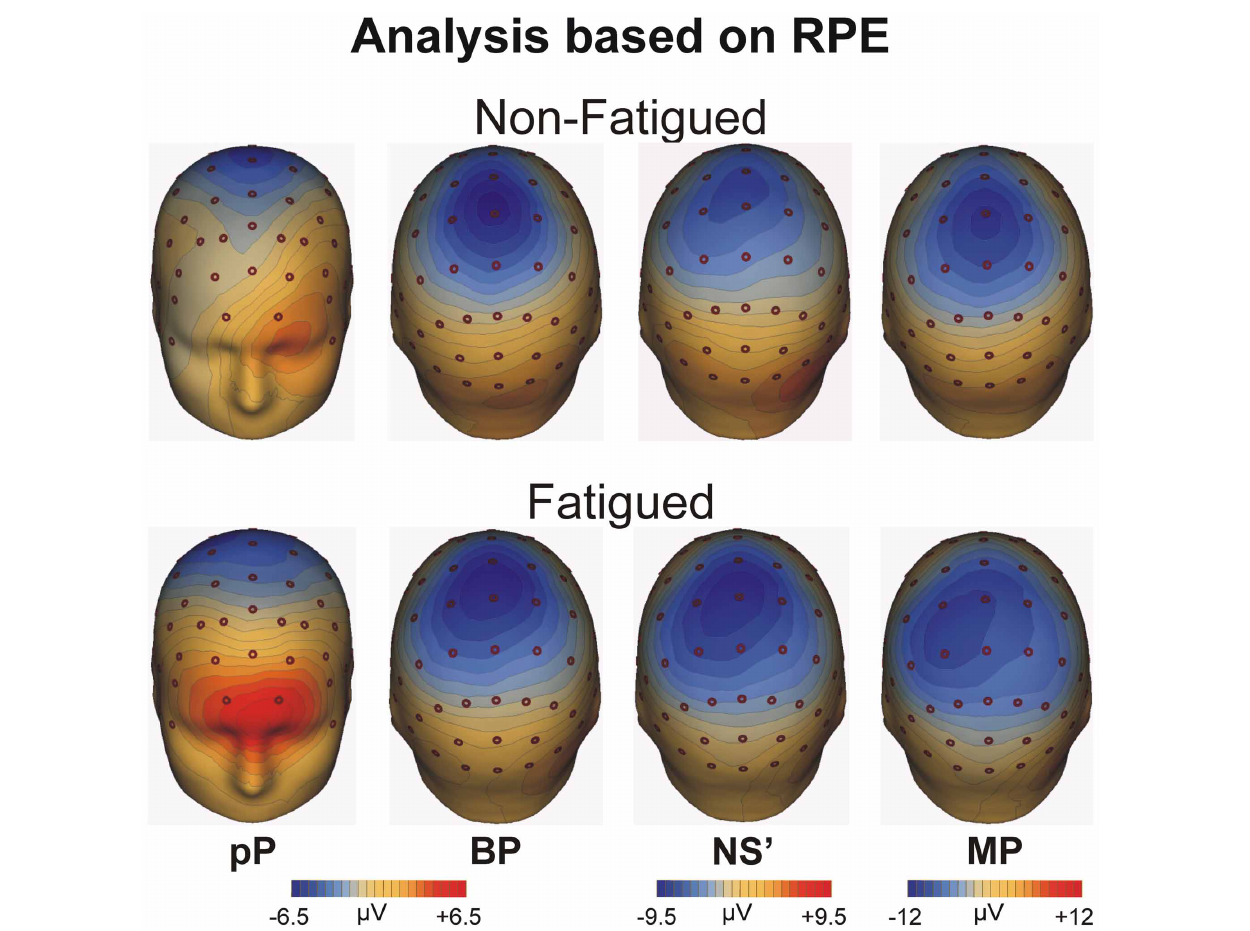
FIGURE 4 | Topographical maps of the MRCP averaged across all blocks for the fatigue and non-fatigued RPE cohorts for the pP, BP, NS’, and MP peak